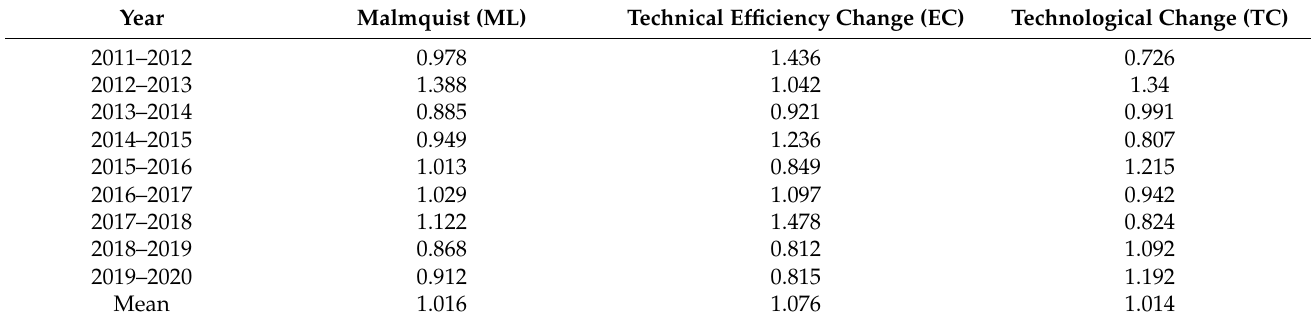
Table 4. Dynamics of environmental efficiency of construction waste generation in China. Malmquist (ML) Technical Efficiency Change